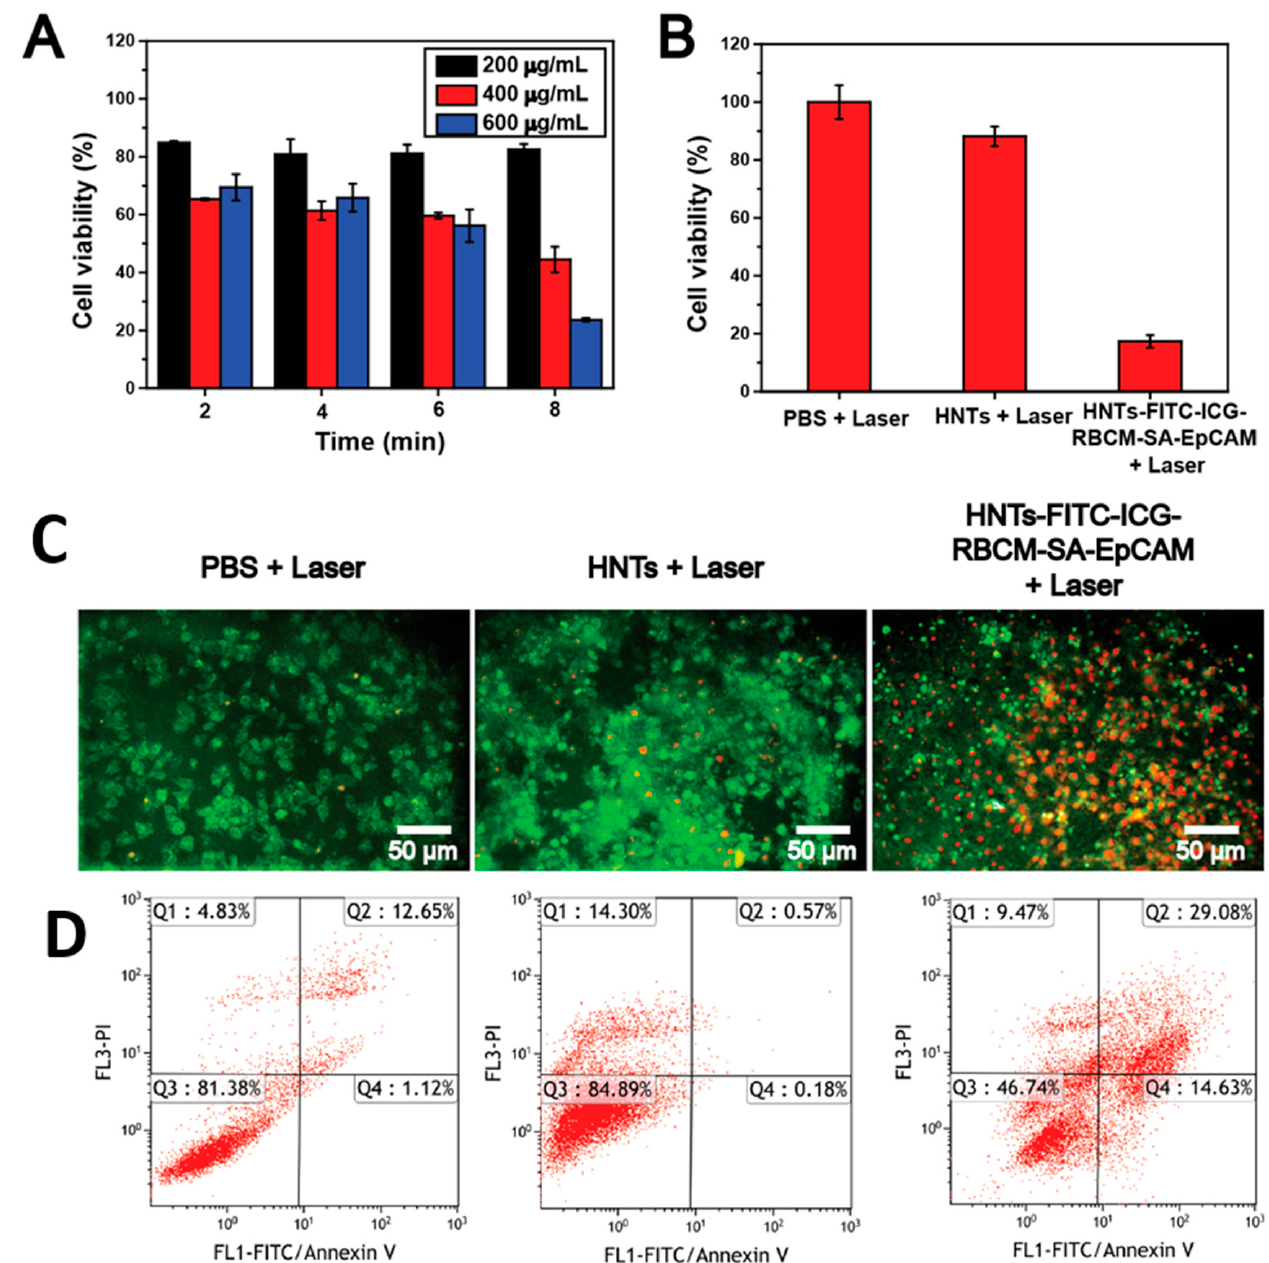
Figure 6. Cell viability ( A ) of MCF-7 cells cultured with different concentrations of HNTs-FITC-ICG-RBCM by irradiation with 808 nm laser at 1.5 W/cm 2 ; cell viability ( B ), AO/EB staining photo ( C ) and ratio of apoptosis ( D ) of MCF-7 cultured with PBS, HNTs and HNTs-FITC-ICG-RBCM-SA-EpCAM (concentration: 400 µ